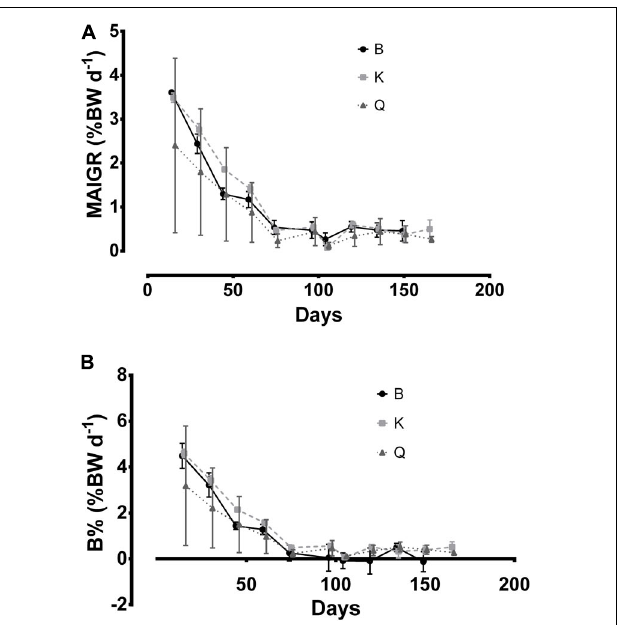
FIGURE 4 | Mean absolute instantaneous growth rate (MAIGR,%BW d - 1 ; A ) and mean biomass relative increase index (B%,%BW d - 1 ; B ) values for cuttlefish breeders reared in different tank types during the growth stage. Data are presented in offset. Bars represent standard deviation.